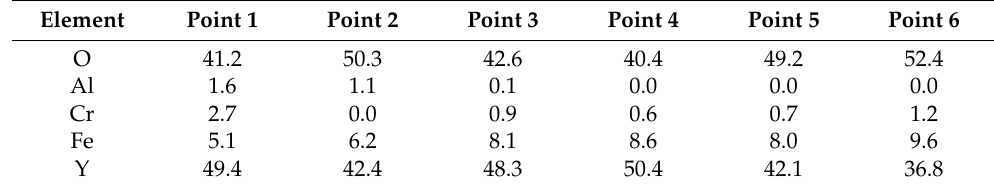
Table 1. Results of EDS point analysis of the dispersoid. Results are presented in atomic percent. Element Point Element